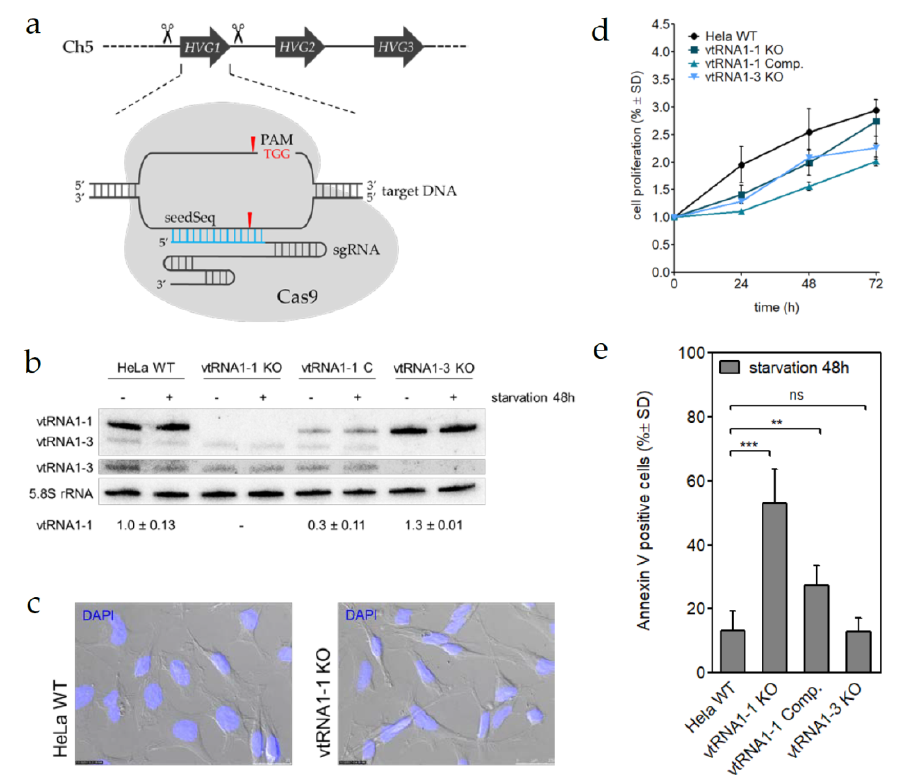
Figure 1. Vault RNA1-1 (vtRNA1-1) knock-out stimulates starvation-induced apoptosis. ( a ) Schematic representation of the genome editing strategy to remove a non-coding RNA gene. Up- and downstream cleavage sites are indicated. ( b ) Northern blot analysis was used to confirm successful genomic editing and vtRNA1-1 complementation in HeLa cell replicas. vtRNA levels were probed in cells either grown in complete media ( − ) or starved for 48 h ( + ). The vtRNA1-3 panel is shown a second time with enhanced contrast settings. 5.8S rRNA serves as internal loading control. ( c ) Light microscopic assessment of cell morphology. The bright-field picture was overlaid with the blue channel to visualize DAPI stained cell nuclei. ( d ) Growth curve over 72 h, measured with the MTT proliferation assay of HeLa WT, vtRNA1-1, and vtRNA1-3 knock-out cells and vtRNA1-1 complementation cells. MTT assay data shows the normalized mean values and the standard deviation from triplicates. ( e ) HeLa cells with (WT, vtRNA1-1 Comp.) or without (vtRNA1-1 KO, vtRNA1-3 KO) vtRNA expression were cultured for 48 h in starvation medium containing chloroquine and the amount of apoptotic cells was determined by FACS analysis after Annexin V and 7-AAD staining. This data is the mean and standard deviation of at least three independent experiments. The number of apoptotic cells in untreated control samples was subtracted from the starved samples and was usually <10%. Significant differences were determined using the two-tailed unpaired Student’s t -test (*** p < 0.0001, ** p < 0.001). By using stable lentiviral transductions, we successfully complemented the vtRNA1-1